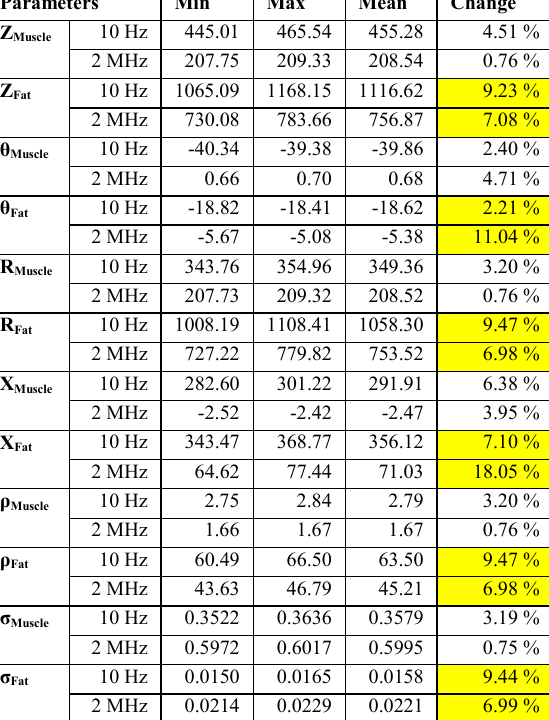
Figure-10: Algebraic mean of the ρ and σ of chicken muscle tissue paste and fat tissue: (a) ρ Mean , (b) σ Mean Table-1: Variation of impedance parameters of muscle tissue paste and fat tissue samples (Z Muscle Paste , θ Muscle Paste , R Muscle Paste , X Muscle Paste , ρ Muscle Paste , σ Muscle Paste , Z Fat , θ Fat , R Fat , X Fat , ρ Fat and σ Fat .) for 10 Hz to 2